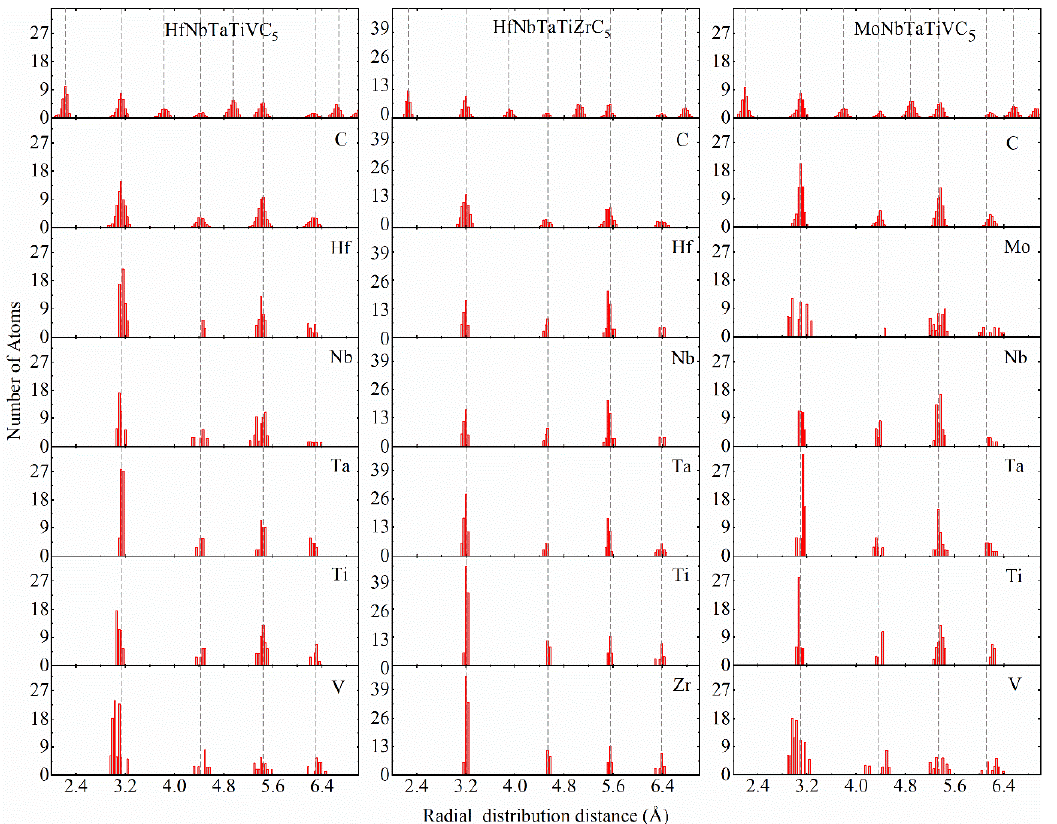
Figure 4. The number of atomic pairs as a function of the radial distribution distance for the present HEC with lattice distortion. The black vertical dot lines stand for the ideal lattice position of different nearest neighboring atomic pairs.